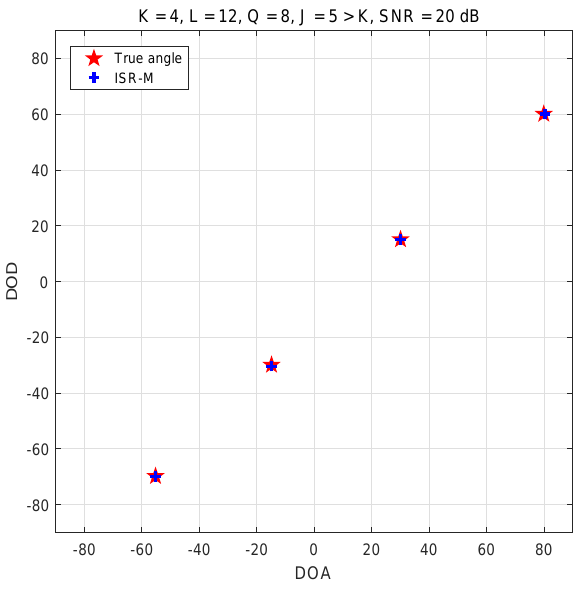
Figure 6. Target localization performance of the proposed ISR-M method, J = 5 > K =